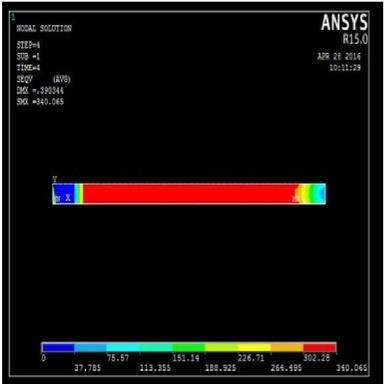
Simulation Results of Tensile Test Specimen at load 5787.9 N.